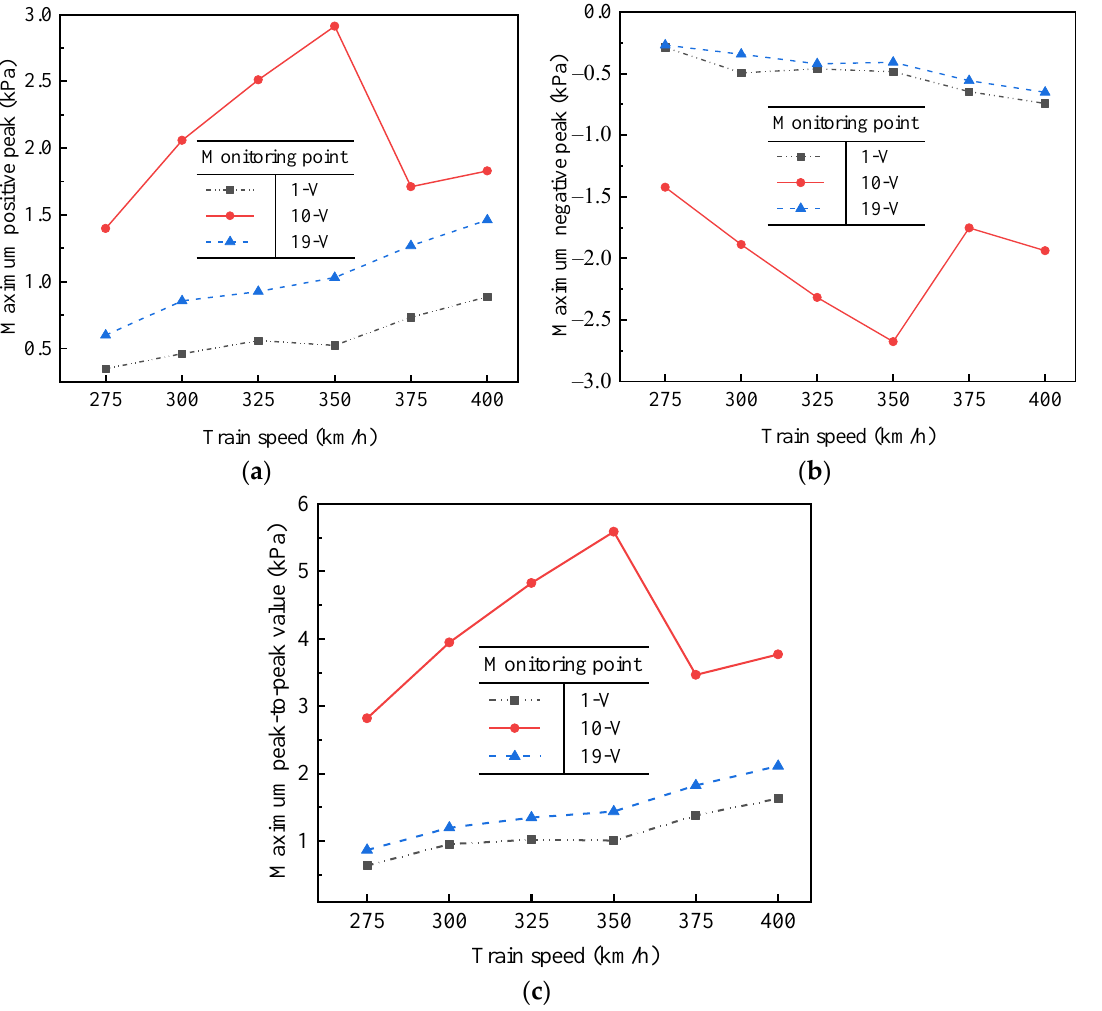
Figure 21. Maximum peak pressure values at different train speeds of typical monitoring points in Stage III. ( a ) Maximum positive peak; ( b ) Maximum negative peak; ( c ) Maximum peak-to-peak